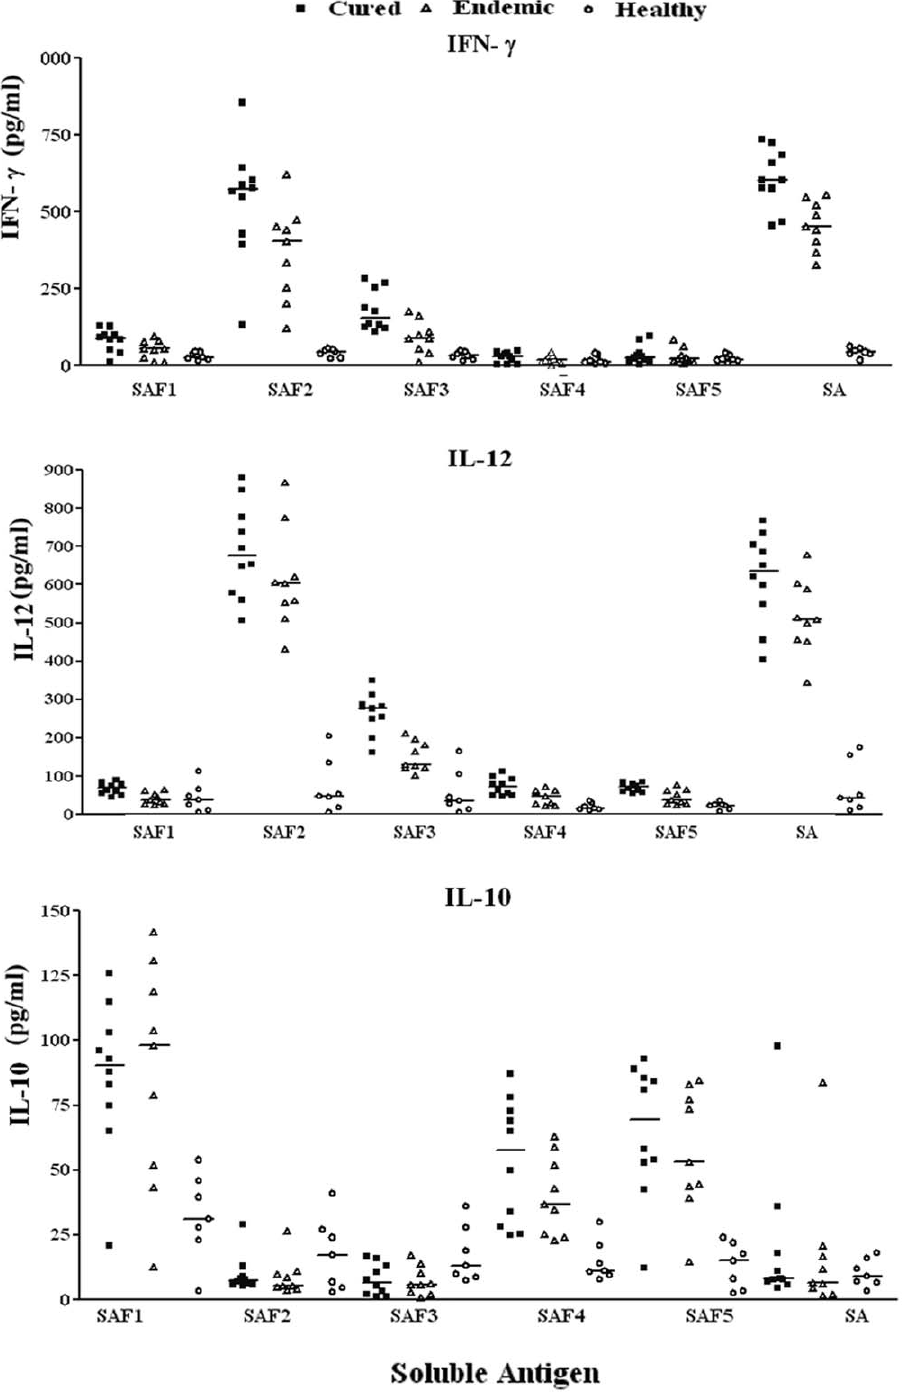
Figure 6. Th1/Th2 cytokine levels (IFN- c , IL-12 p 40, IL-10) of PBMCs from cured VL patients (full course of treatment with Amphotericin B) ( & ), endemic ( m ) and healthy (o) individuals against soluble antigenic fractions used at a concentration of 10 m g/ ml (1 m g/well). The results are presented in the graph as for individual human sample along with horizontal bar representing the median.